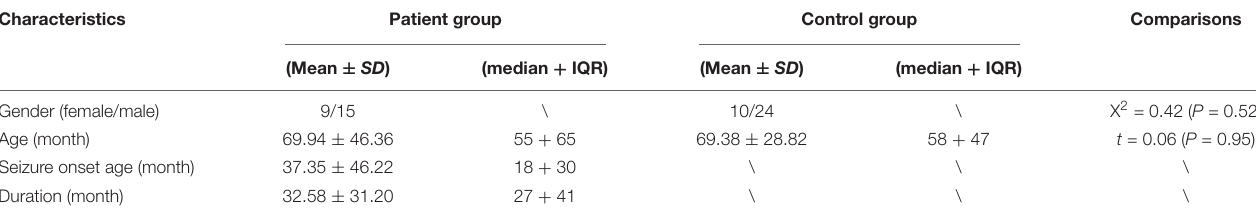
TABLE 1 | Demographic and clinical information data of the subjects.